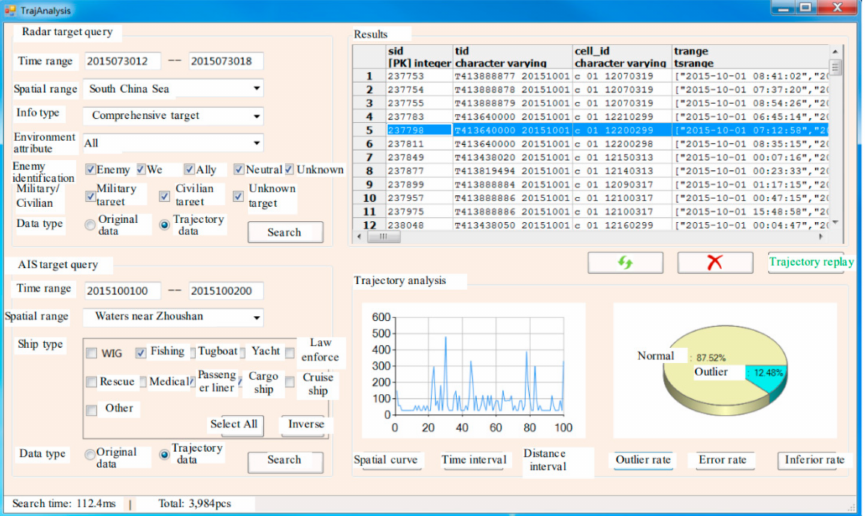
Figure 15. STDMAS trajectory analysis